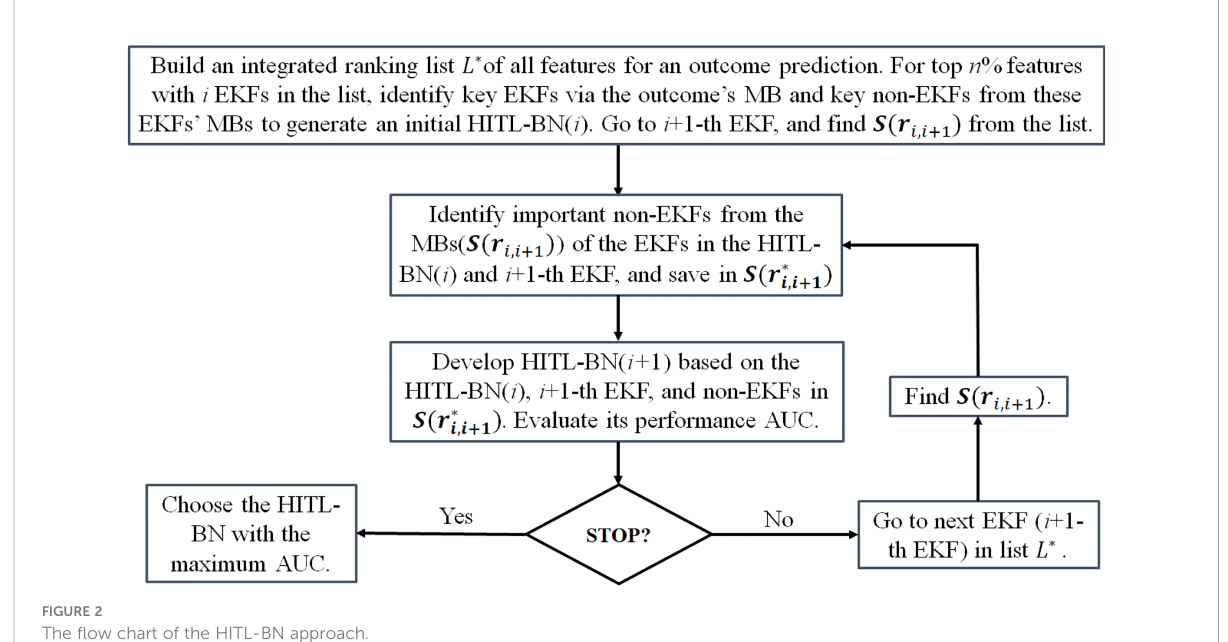
FIGURE 2 The fl ow chart of the HITL-BN